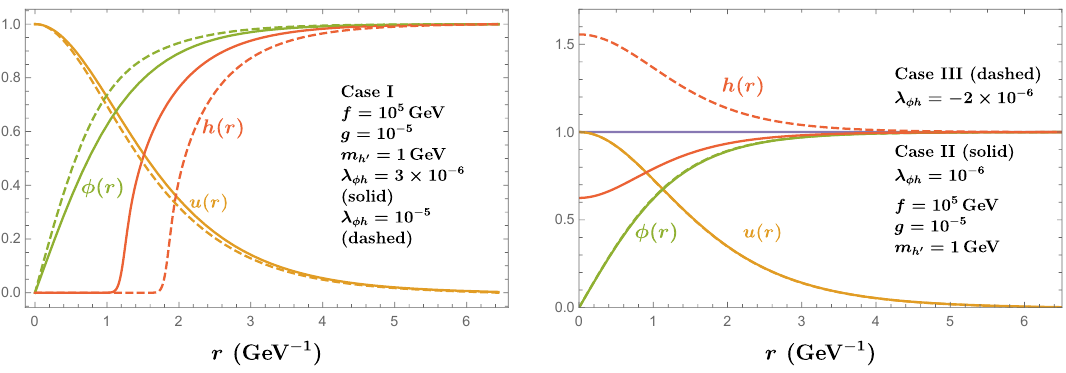
Figure 1 . Representative pro(cid:12)les as a function of radius for various cases de(cid:12)ned in (2.14) are shown here in the \small g " scenario. Parameters have been chosen to obtain v = 246 GeV and m h = 125 GeV in all